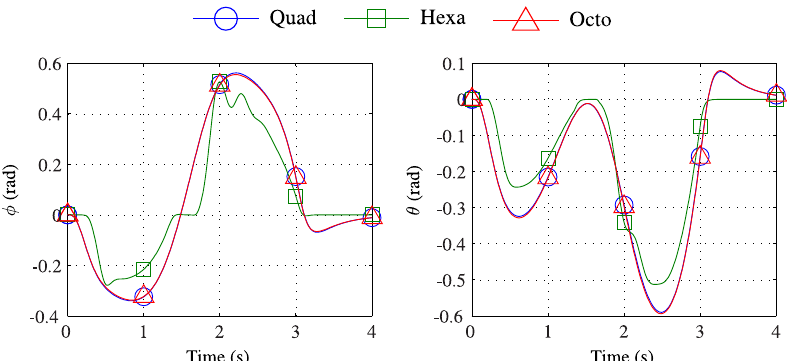
Figure 17. Dynamic response in roll and pitch for each multirotor when accurately tracking a commanded